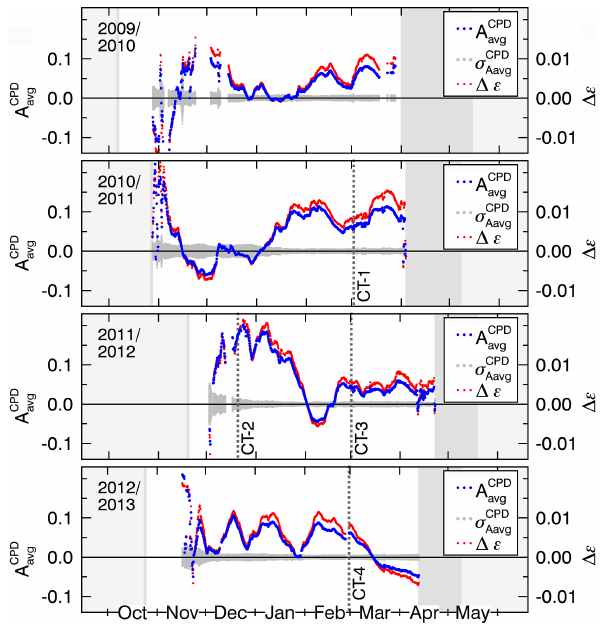
Figure 11. Average anisotropy of the snowpack, A CPD avg , determined during dry snow conditions for the winter seasons from 2009 to 2013. The anisotropy was derived from the CPD measured by the SnowScat instrument. The standard deviation σ CPD of A CPD avg , cal- Aavg culated from measurements at different frequencies and incidence angles, is shown as the time-varying gray bar below the anisotropy. The dielectric anisotropy (cid:49)ε = ε x − ε z is shown in red. The dark gray shading in April/May indicates the period of snow melt; the light gray shadings (October/November, May/June) indicate snow- free conditions. The four dashed vertical lines show the times when the anisotropy was measured by computer tomography (CT-1, -2, -3, and -4).